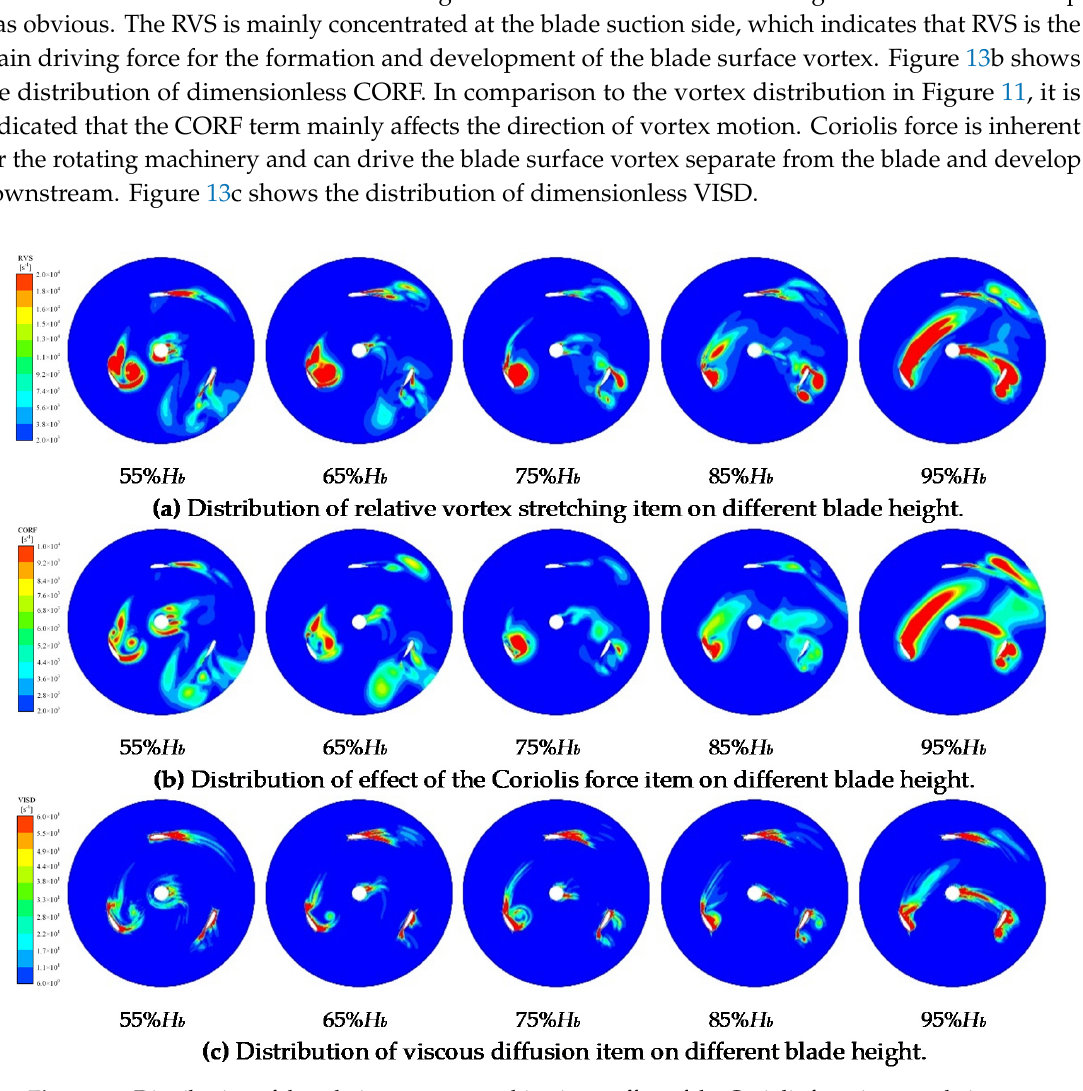
Figure 13. Distribution of the relative vortex stretching item, effect of the Coriolis force item, and viscous diffusion item on different blade height at λ = 1.0. ( a ) Relative vortex stretching item; ( b ) Coriolis force item; ( c ) Viscous diffusion item.